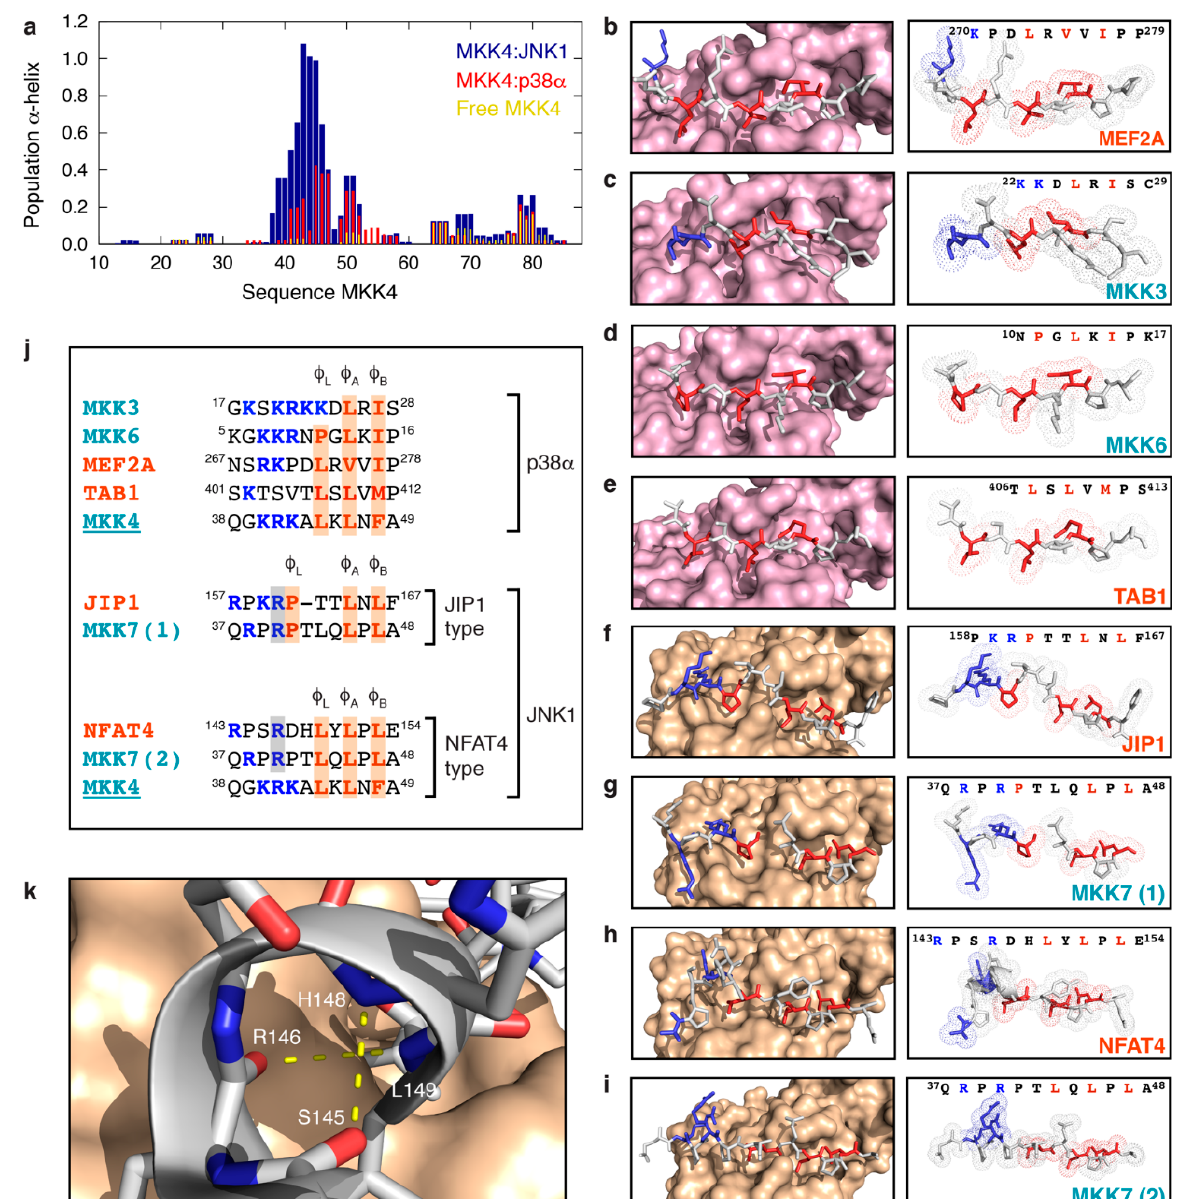
Figure 6. Structural comparison of complexes between docking site motifs and p38 α or JNK1. ( a ) Population of α -helix in the free state of MKK4 (yellow) and the MKK4:JNK1 (blue) and MKK4:p38 α (red) complexes calculated from the experimental chemical shifts. ( b – e ) Structure of p38 α (surface representation) in complex with the docking site motifs (sticks) of MEF2A (PDB 1LEW), MKK3 (PDB 1LEZ), MKK6 (PDB 2Y8O) and TAB1 (PDB 4KA3). Labels in turquoise and orange are upstream kinases and scaffold proteins or MAPK substrates, respectively. ( f – i ) Structure of JNK1 (surface representation) in complex with the docking site motifs (sticks) of JIP1 (PDB 1UKH), MKK7 conformation 1 (PDB 4UX9), NFAT4 (PDB 2XRW) and MKK7 conformation 2 (PDB 4UX9). ( j ) Structure-based sequence alignment of JNK1 and p38 α docking site motifs. Orange shading highlights the residues that occupy the three MAPK hydrophobic pockets, while gray shading indicates positively charged residues that clearly interact with the CD groove as observed in the crystal structures. ( k ) Zoom on the helical turn adopted by the docking site motif of NFAT4 in complex with JNK1. Two hydrogen bonds (residue i to i + 3 ) are formed to stabilize the helical